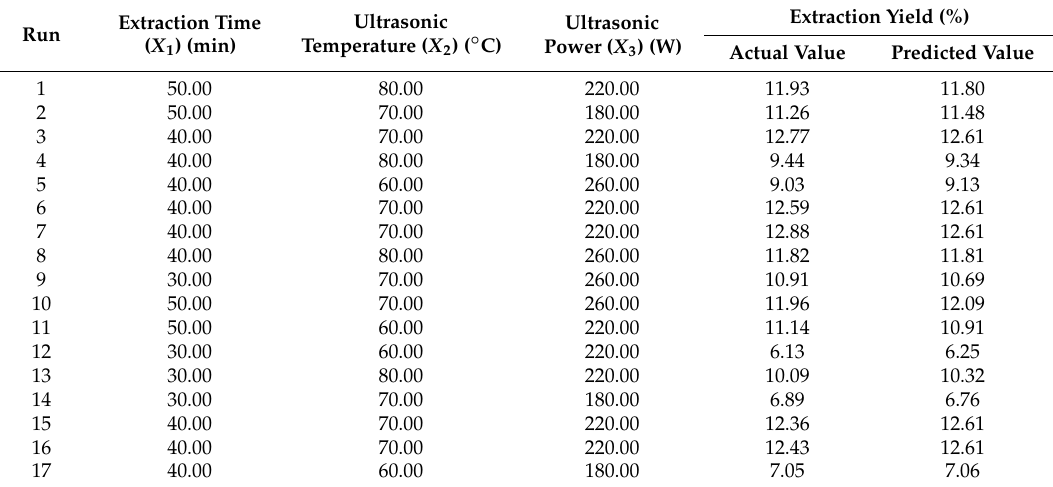
Table 1. Box–Behnken experimental design and results for extraction